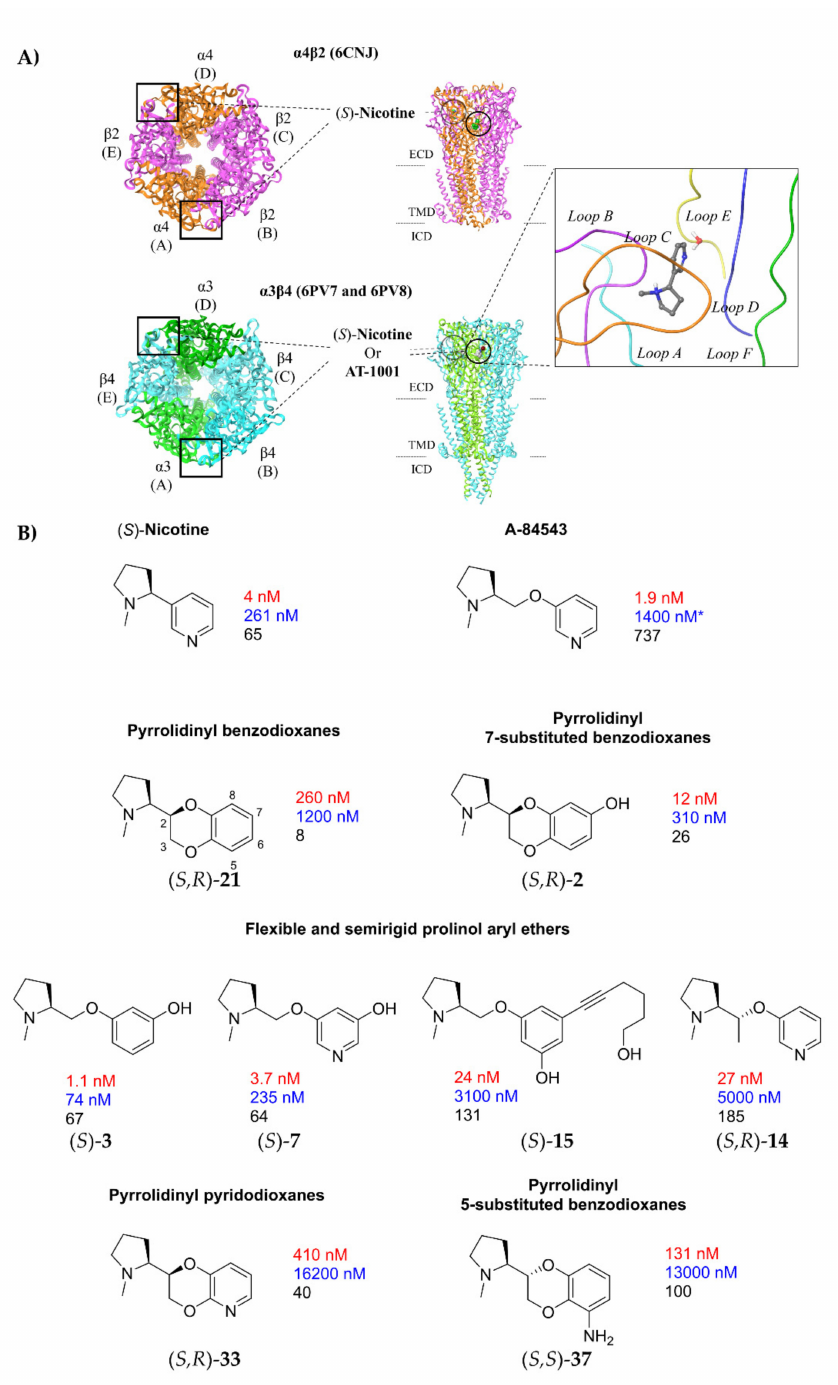
Figure 1. ( A ) Schematic overview of the α 4 β 2 and α 3 β 4 nAChRs architecture (adapted from 6CNJ, 6PV7, and 6PV8). The α - β localization of the orthosteric binding sites, where ( S )- nicotine (6CNJ or 6PV7) and AT-1001 (6PV8) bind, are shown. Table 6. PV7, together with an overview of the loop composition of the binding site, is represented. ( B ) Binding affinities (K i , nM) for rat α 4 β 2 nAChR (in red) and for human α 3 β 4 nAChR (in bleu) and α 4 β 2 vs. α 3 β 4 binding selectivity (in black) of some title compounds exhibiting the highest α 4 β 2 affinities. ( S )- nicotine and A-84543 are reported for comparison. Asterisk on α 3 β 4 affinity of A-84543 indicates that it was determined at the rat